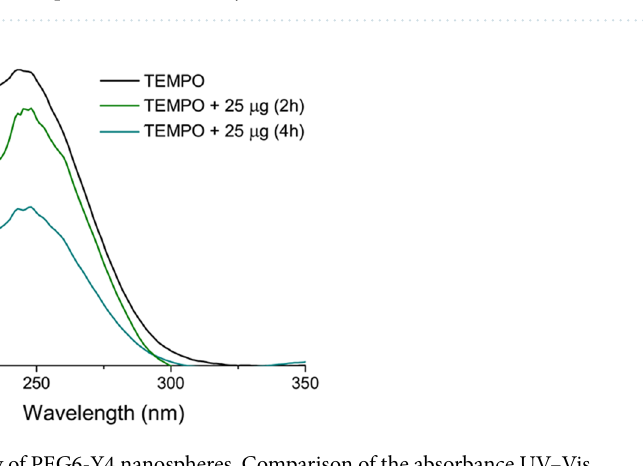
Figure 4. Selected SEM micrographs for self-assembled PEG6-Y4 nanostructures drop-casted after heating in stove for 4 h and re-dissolved in MeOH ( a ), H 2 O/MeOH (50/50, v/v ) ( b ) and H 2 O/MeOH (0.025/99.75, v/v ) ( c ). Magnification and scale bar for all the samples are 12,0000×, 1 µm.